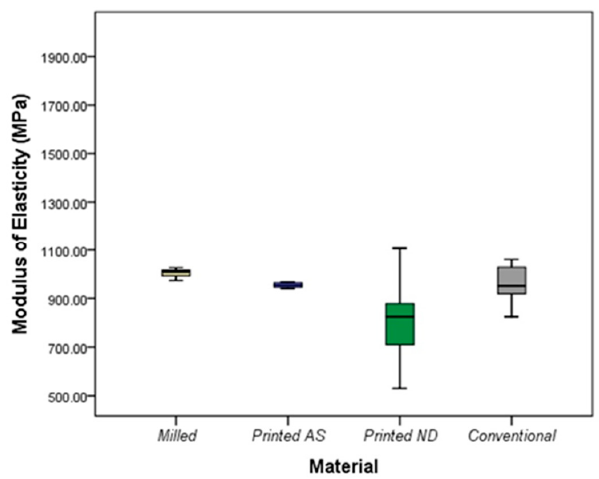
Figure 6. Elastic modulus (MPa) of the studied materials.